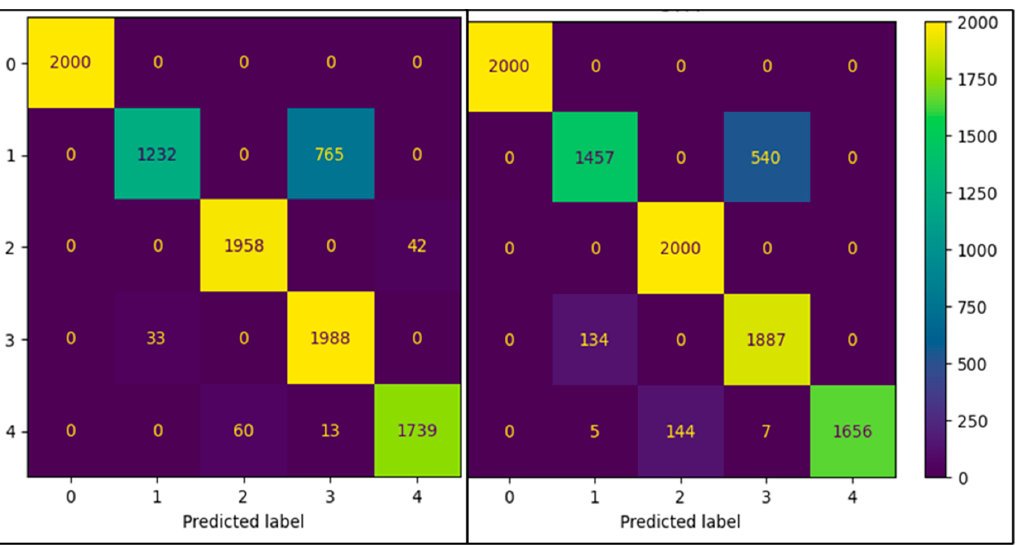
Figure 5. Correlation matrix for leave-out 30 W for RFC ( left ) and SVM ( right ) using the maximal intensity and corresponding frequency.